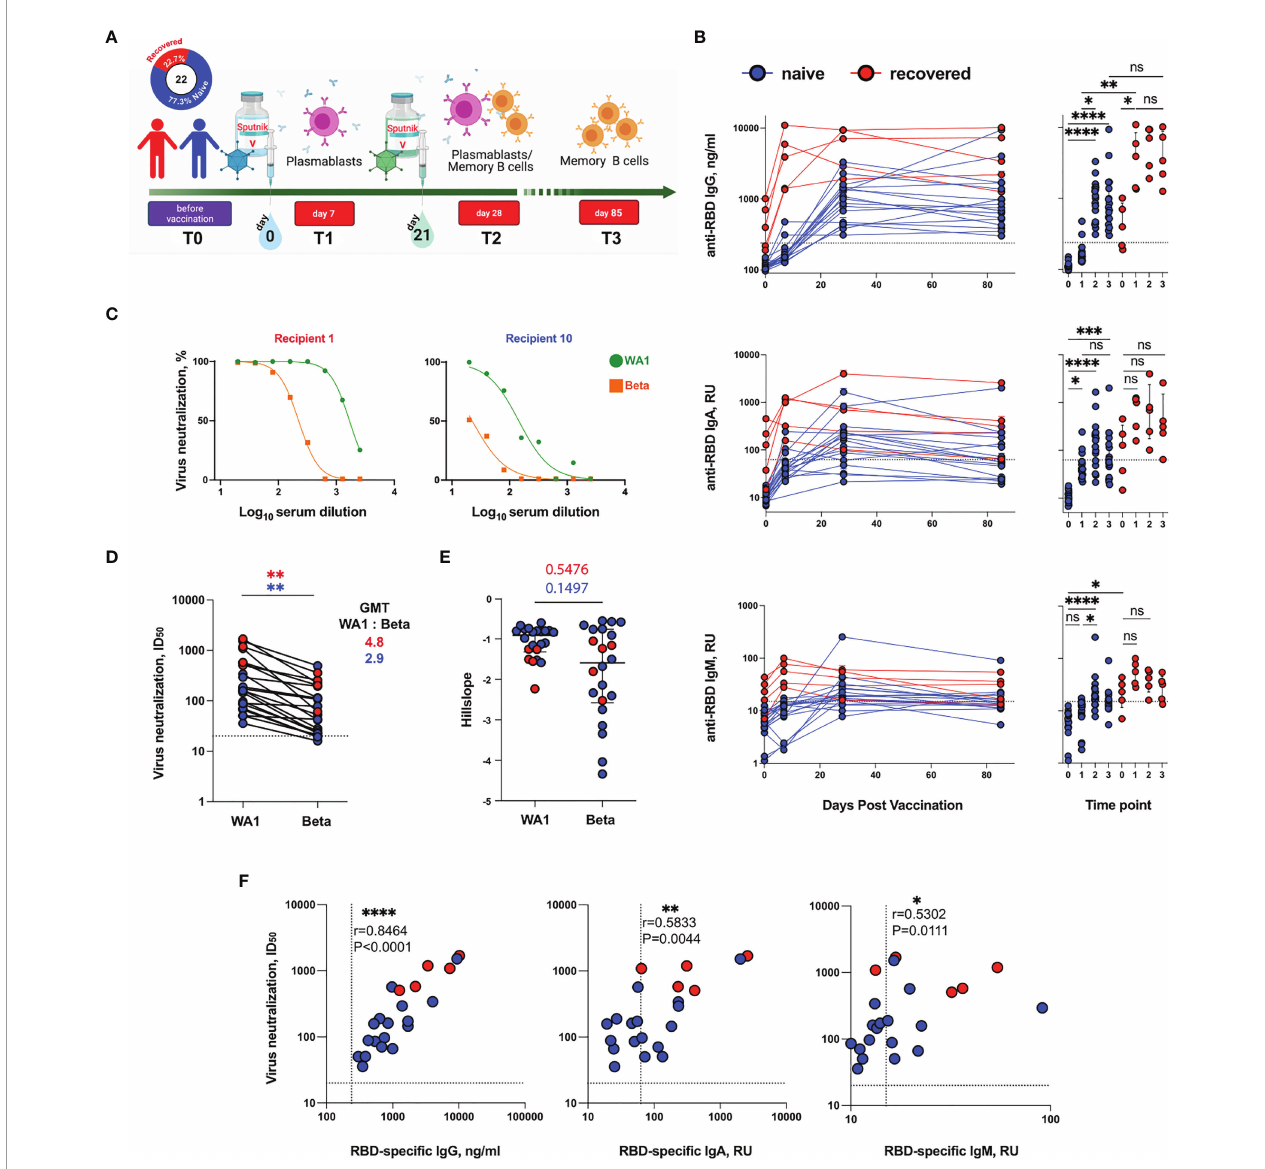
FIGURE 1 | Virus-binding and virus-neutralizing activity of sera from Sputnik V-vaccinated individuals. (A) Study design. (B) Serum anti-RBD IgG (top row), IgA (middle row) or IgM (bottom row) levels for all Sputnik V-vaccinated individuals, measured by ELISA. IgA and IgM levels are shown as a relative units (RU) against a standard convalescent serum. (C) Representative neutralization curves of vaccine-induced sera from one recovered and one naïve individual at T3 time point. (D) Paired analysis of neutralization titers (ID 50 ) against WA1 strain and Beta variant at T3 time point. (E) Analysis of hillslopes of virus neutralization curves for sera from vaccinated individuals. (F) Spearman ’ s correlation between serum virus neutralization half-maximal inhibitory serum dilution (ID 50 ) values and the serum levels of anti-RBD IgG (left panel), IgA (middle panel) and IgM (right panel). Blue and red symbols indicate naïve (n = 17) and recovered (n = 5) participants. Symbols connected by solid lines represent time points considered for each individual. Data are presented as median ± IQR. The dotted lines indicate the threshold for positivity. Statistics were calculated using Mann-Whitney test (comparisons between WA1 strain and Beta variant) or the Kruskal – Wallis test (comparisons between time points and naïve and recovered, *P < 0.05, **P < 0.01, ***P < 0.001, ****P < 0.0001, ns, not signi fi cant. GMT, geometric mean titer; ID 50 , half-maximal inhibitory dilution; IQR, interquartile range; RBD, receptor-binding domain; RU, relative